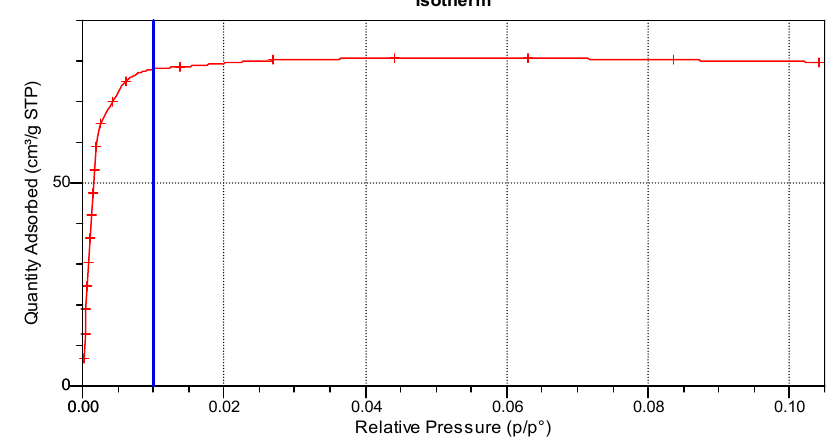
Figure A3. BET isotherm POR-C11.